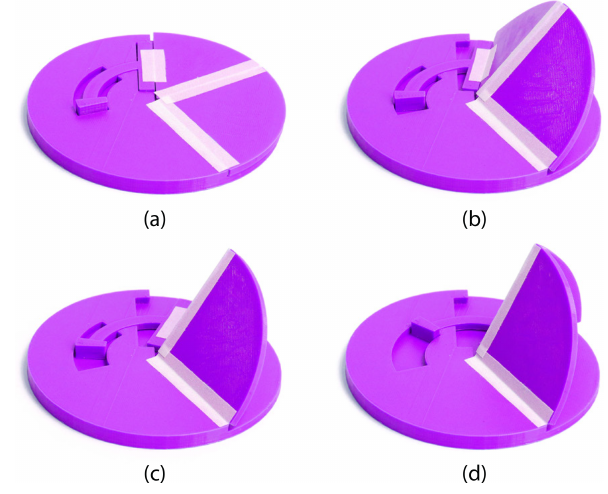
Figure 25. Slider sector panel ThUDS in (a) flat, (b–c) deploying, and (d) deployed states.